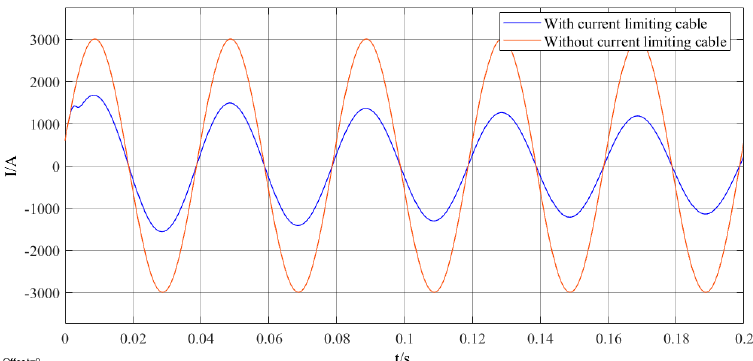
Figure 7. The cable current with and without current limiting cable.